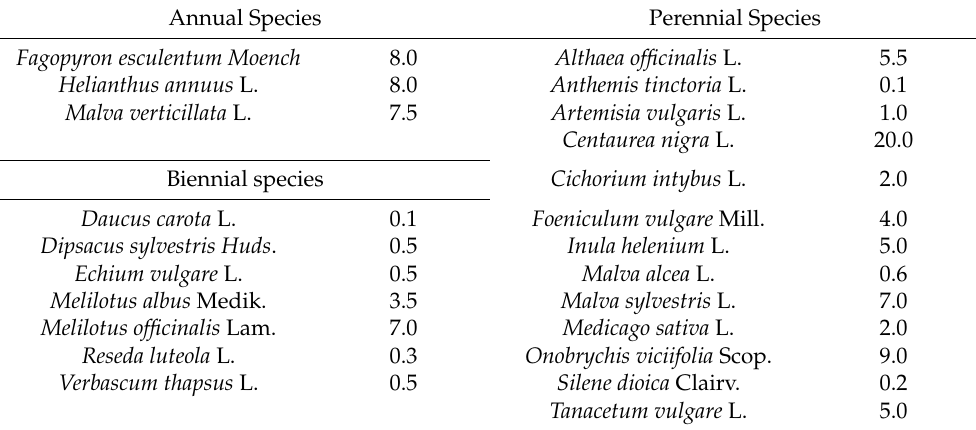
Table 3. Species list of the perennial mixture BG 70 (Saaten Zeller GmbH & Co. KG). Botanical name and weight proportion (%) in the perennial mixture BG